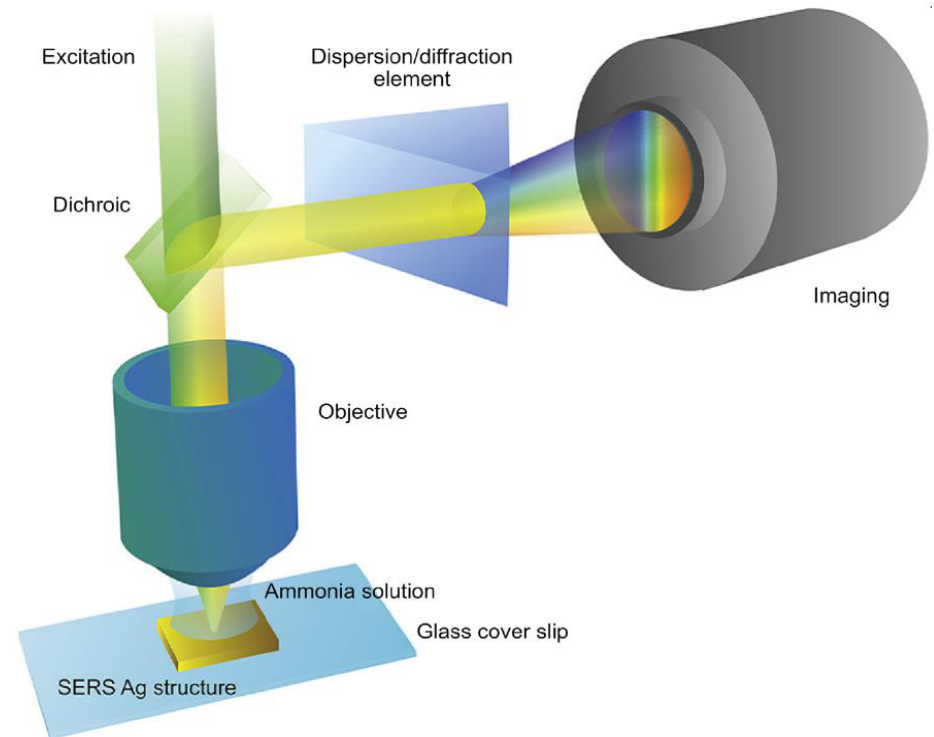
Figure 13. Schematic Diagram of NH 3 Detection by the Surface-Enhanced Raman Scattering (SERS) Approach Proposed by Liu and Colleagues. Reprinted from [143], with permission from Elsevier.